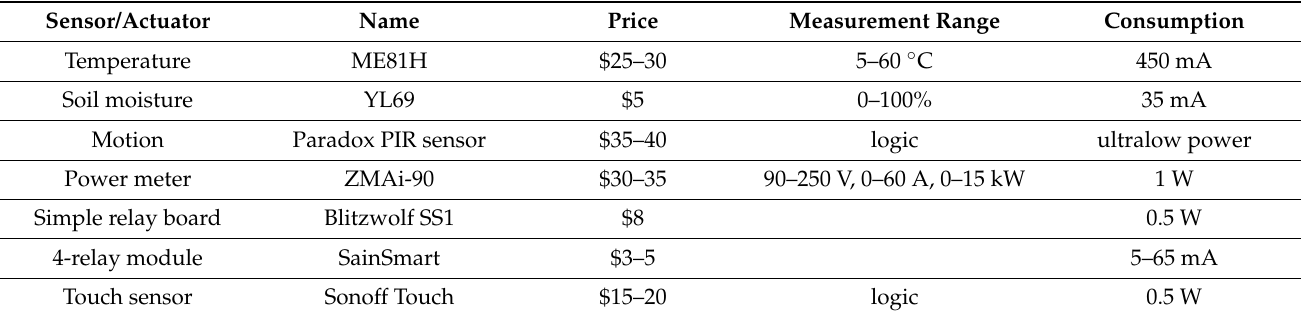
Table 3. Sensors and actuators used by qToggle for this case study.